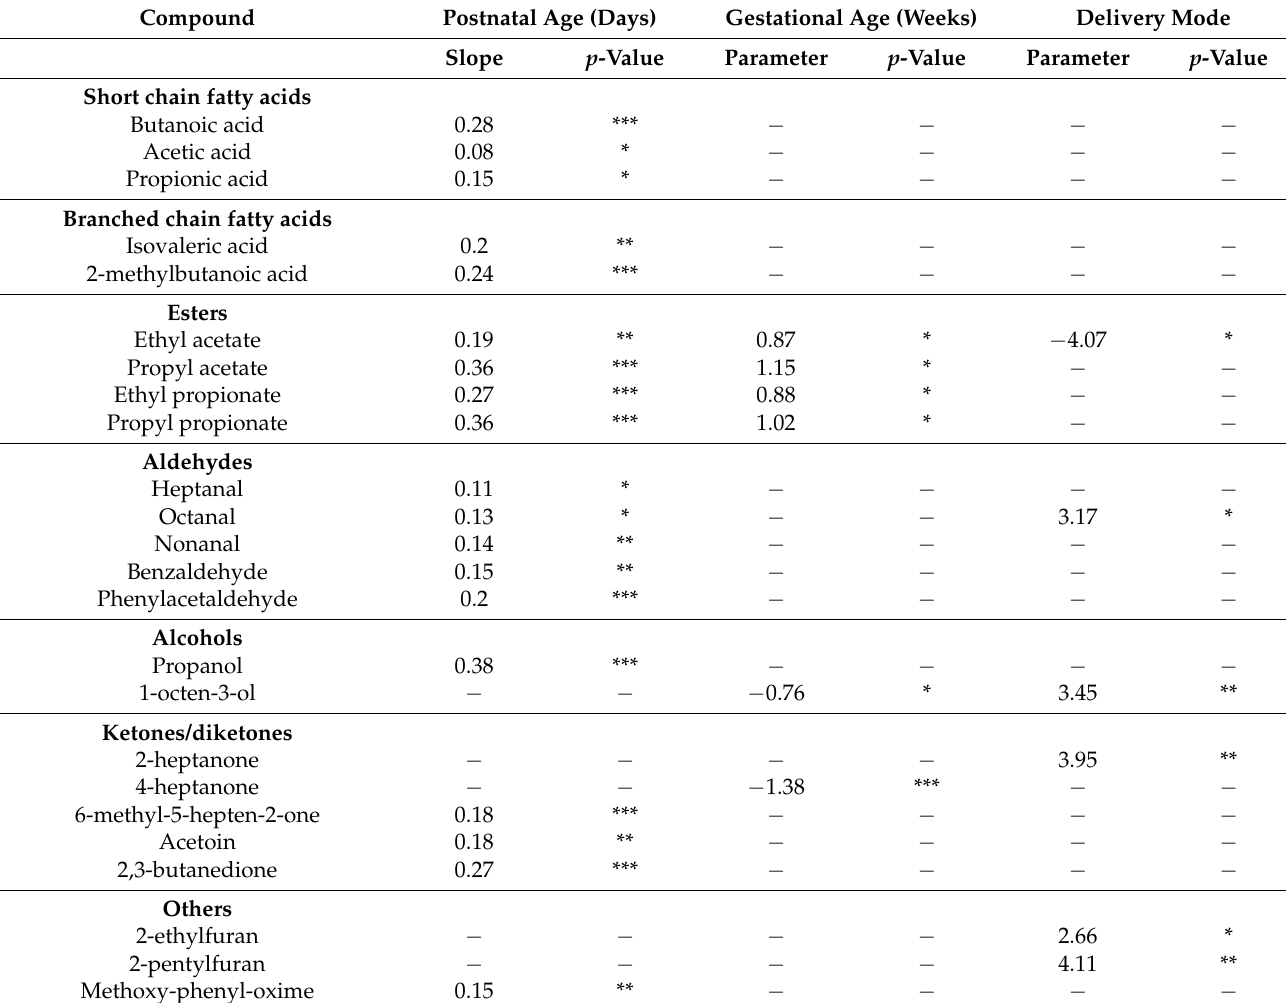
Table 4. List of volatile organic compounds (VOCs) that were influenced by relevant variables obtained with linear mixed-effects (LME) analysis.